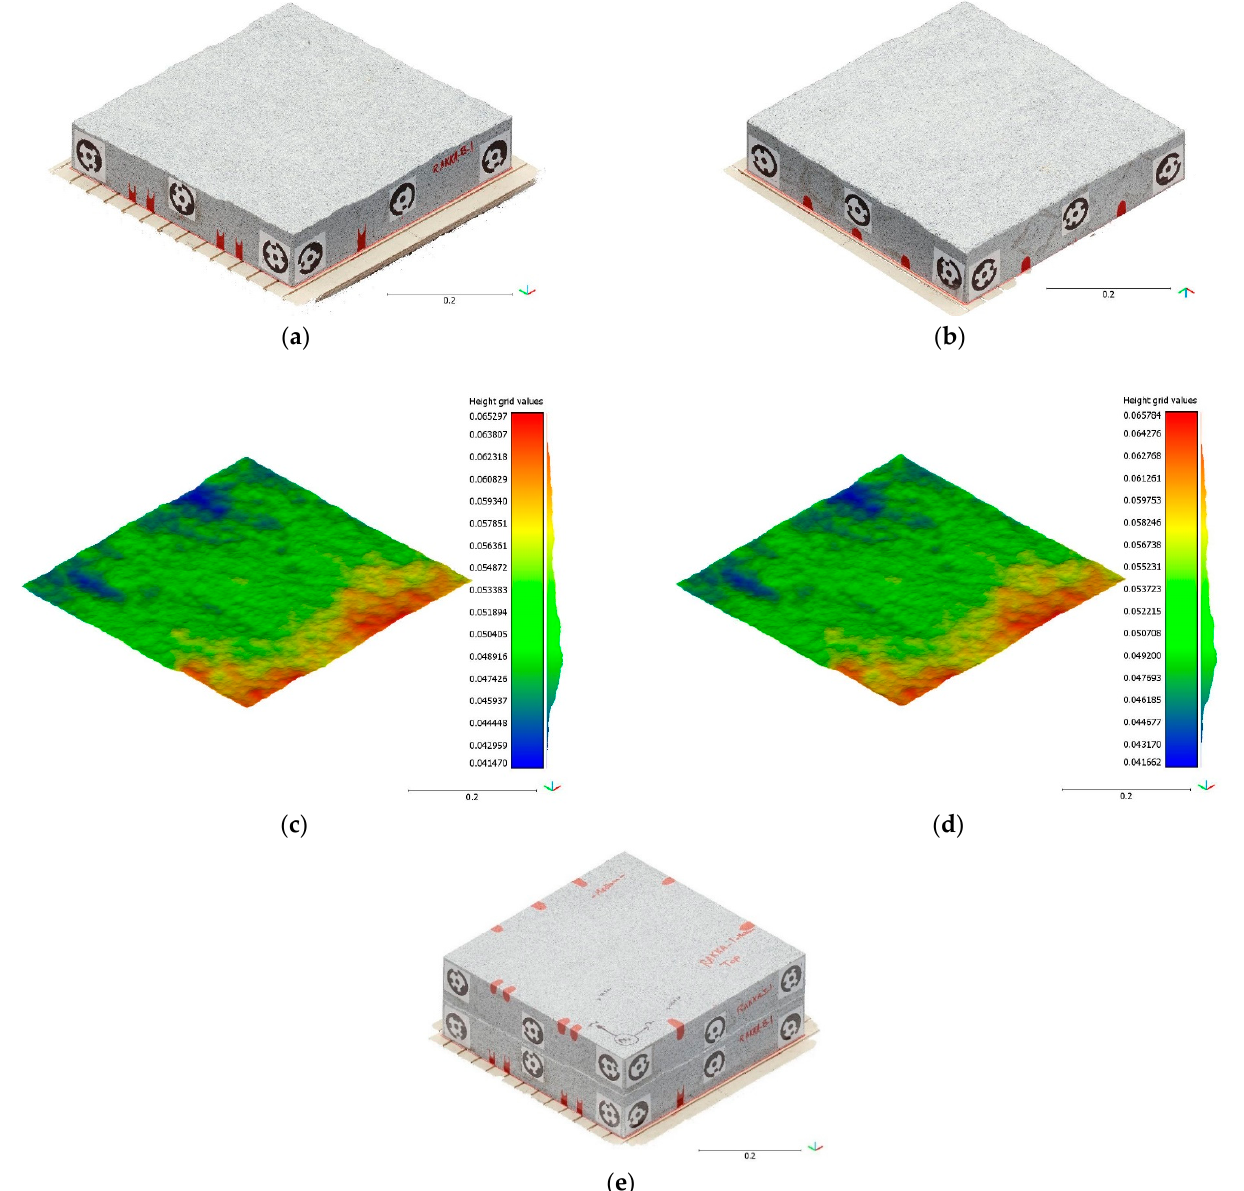
Figure 5. 3D point clouds of the sample reconstructed from the images obtained using Canon DSLR camera, ( a ) the bottom half, ( b ) the top half, ( c ) topography of bottom surface ( d ) topography of top surface, and ( e ) the whole sample.